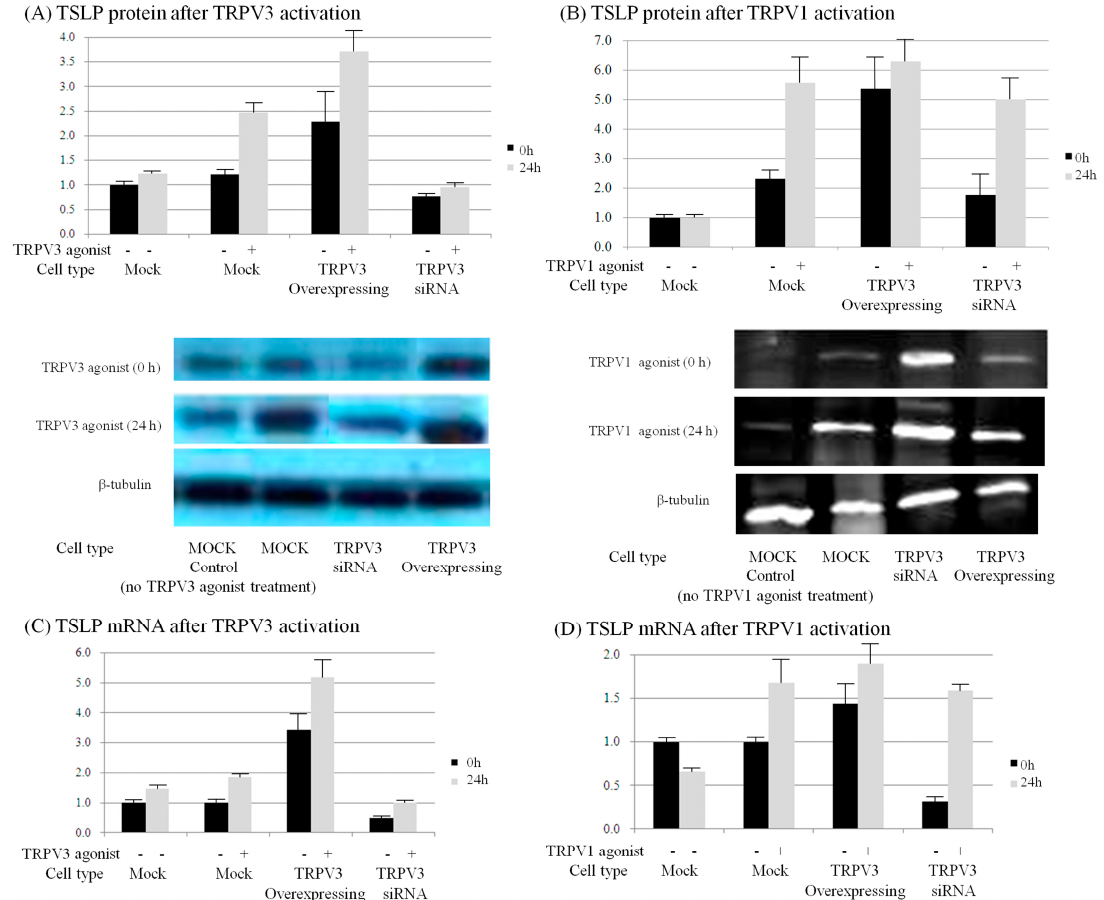
Figure 11. Normal human epidermal keratinocytes (NHEKs) were transfected with TRPV3 overexpressing vector or with siRNA, to analyse the effect of TRPV3 and TRPV1 channels on TSLP expression. Western blotting was conducted to measure the TSLP protein level in response to ( A ) TRPV3 agonist (500 µ M Carvacrol + 200 µ M mixture 2-APB) and ( B ) TRPV1 agonist (1 µ M Capsacin). Quantitative real-time PCR was performed to measure the TSLP mRNA level in response to ( C ) TRPV3 agonist and ( D ) TRPV1 agonist. In normal human epidermal keratinocytes treated with TRPV3 agonist, TSLP mRNA and protein expression increased. The expression of TSLP mRNA was significantly increased by TRPV3 agonist treatment with TRPV3 overexpressed NHEK, but not with TRPV3 knockout NHEK with siRNA. The expression of TSLP mRNA and protein was also increased by TRPV1 agonist treatment. There was no significant increase in TSLP protein expression in TRPV1 agonist treatment with TRPV3 overexpressed NHEK and no increase in TRPV3 knockout NHEK. NC: keratinocytes from normal control; B (N): keratinocytes from nonpruritic burn scar; B (P): keratinocytes from pruritic burn scar; NHEK: normal human epidermal keratinocyte; TSLP: thymic stromal lymphopoietin; TSLPR: thymic stromal lymphopoietin receptor; Error bars: standard deviation of the mean value obtained from three experiments, each performed in